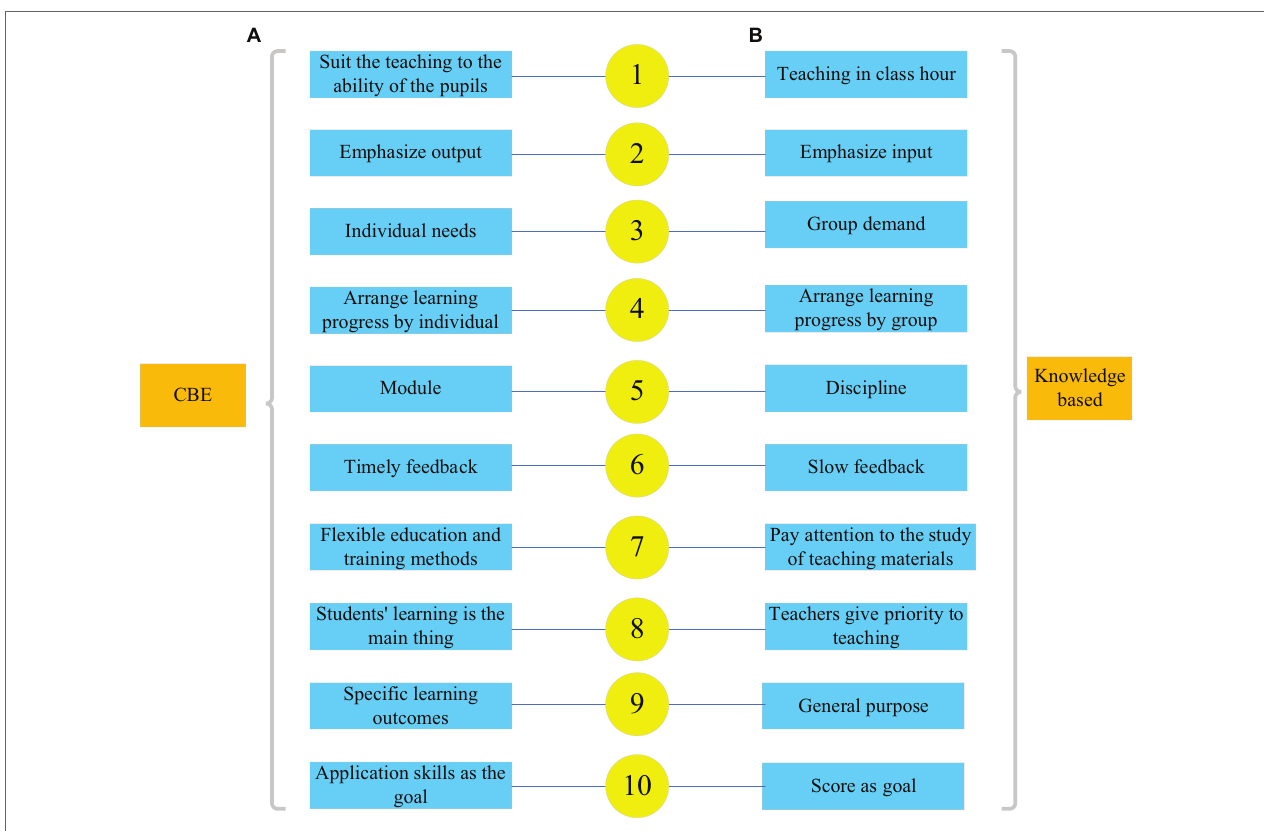
FIGURE 2 | Competency-based education (CBE) versus knowledge-based education (KBE) (A) CBE; (B)